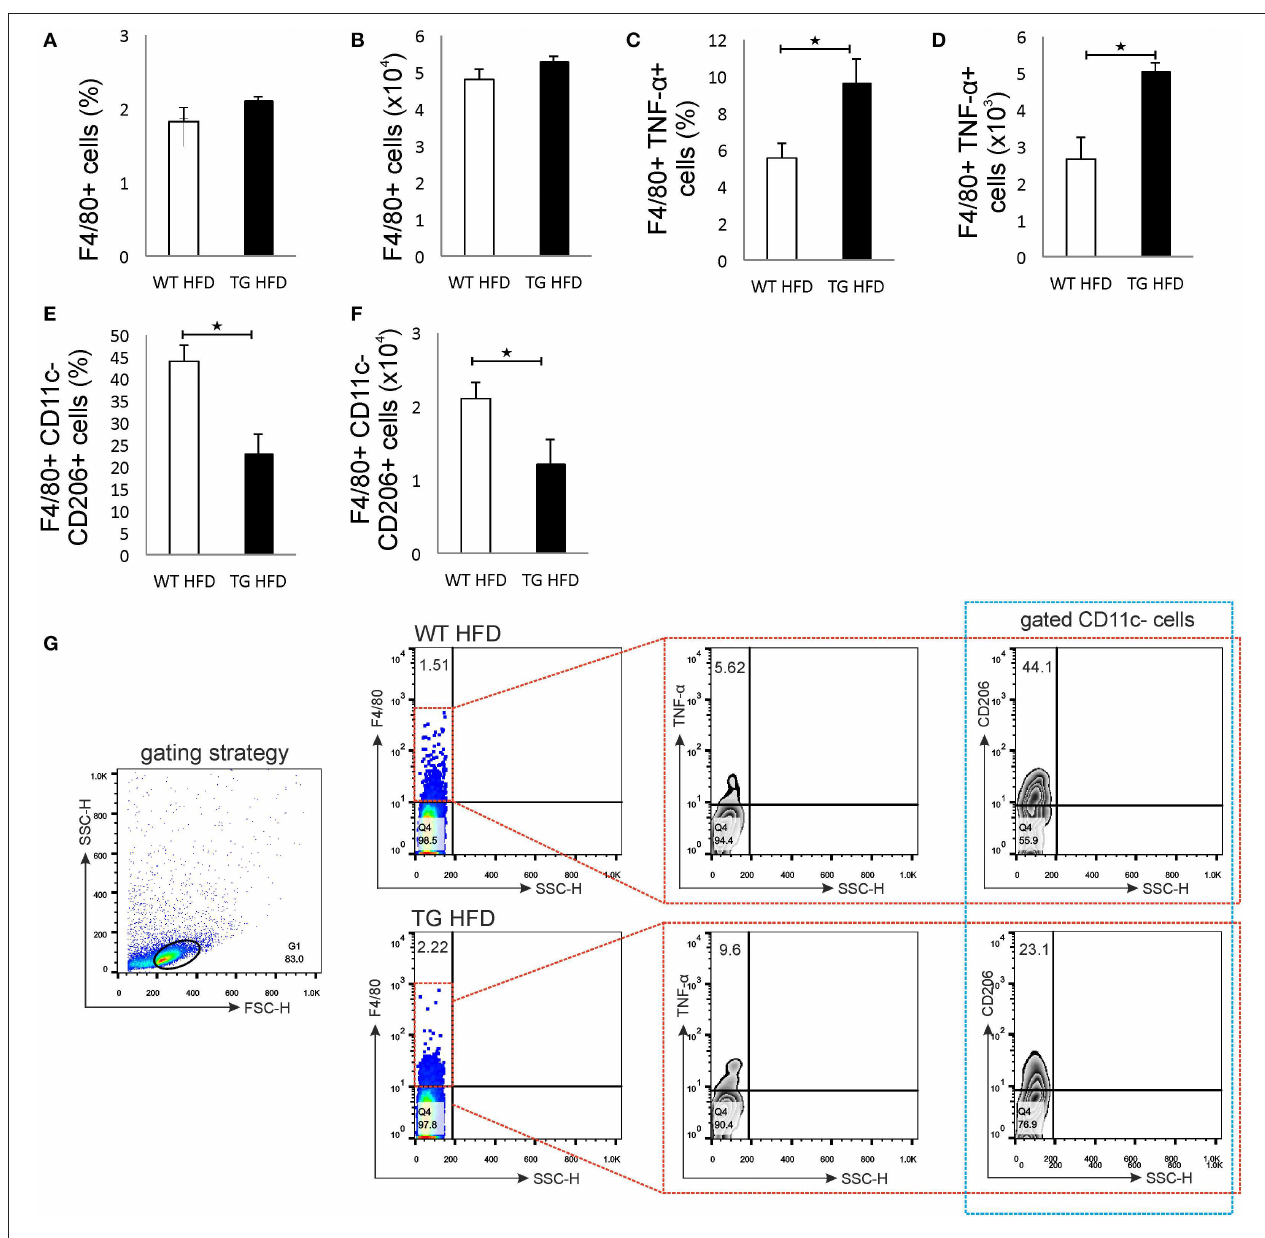
FIGURE 6 | Islet inflammation is accompanied by an enhanced number of F4/80 + TNF- α + M1 macrophages and a decreased number of F4/80 + CD206 + M2 macrophages in pancreatic lymph nodes. Percentages and total numbers of F4/80 + macrophages in pancreatic lymph nodes. There were no differences in the percentage and number of F4/80 + macrophages in mice on HFD (A,B) . Percentages and total numbers of F4/80 + TNF- α + M1 macrophages. Percentage and number of proinflammatory M1 F4/80 + TNF- α + macrophages were significantly higher in pancreatic lymph nodes of TG mice on HFD compared to WT (C,D) . Percentages and total numbers of F4/80 + CD11c − CD206 + M2 macrophages. The percentage and number of M2 F4/80 + CD11c − CD206 + macrophages were significantly lower in pancreatic lymph nodes of TG mice on HFD (E,F) . Gating strategy, representative dot and contour plots for F4/80 + , F4/80 + TNF- α + , and F4/80 + CD11c − CD206 + cells in pancreatic lymph nodes (G) . Data from two experiments with 10–15 mice per group are shown as mean ± SEM; by Mann-Whitney U -test and independent-sample Student’s t -test; * p <